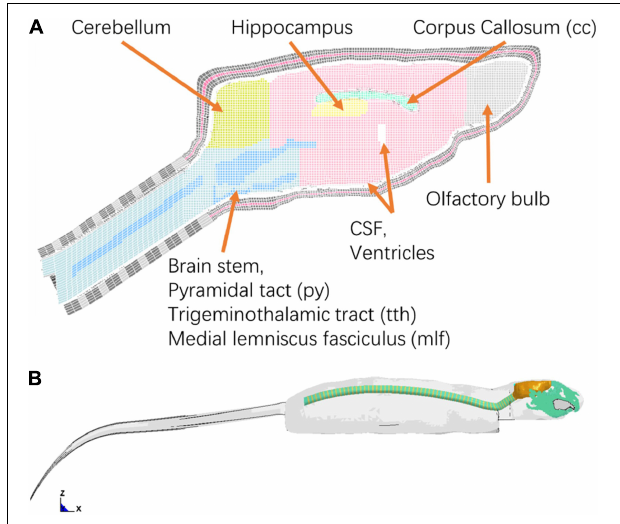
FIGURE 2 | (A) Finite element mesh of the rat brain (Midline sagittal section view); (B) A lateral view of rat whole body FE